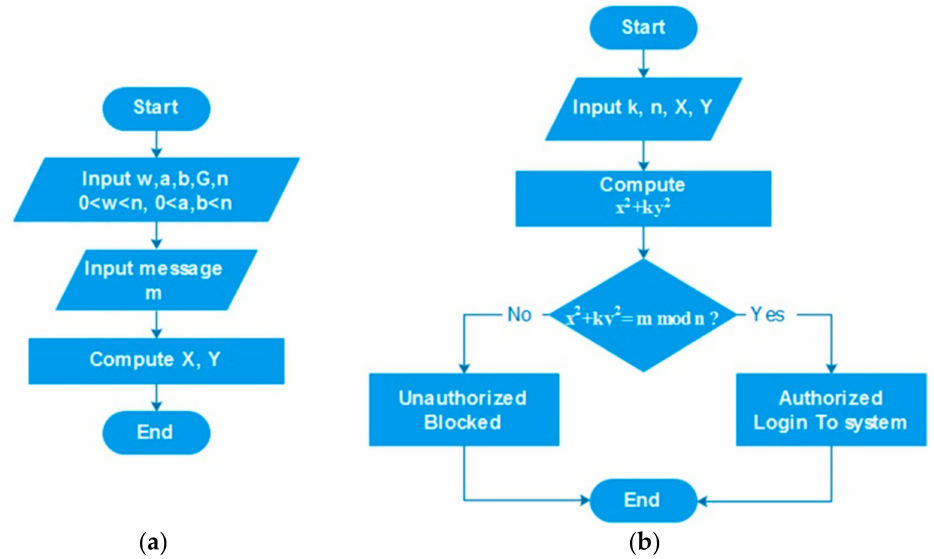
Figure 4. Traditional Ong–Schnorr–Shamir (OSS) signature scheme: ( a ) transponder and ( b ) inter- rogator